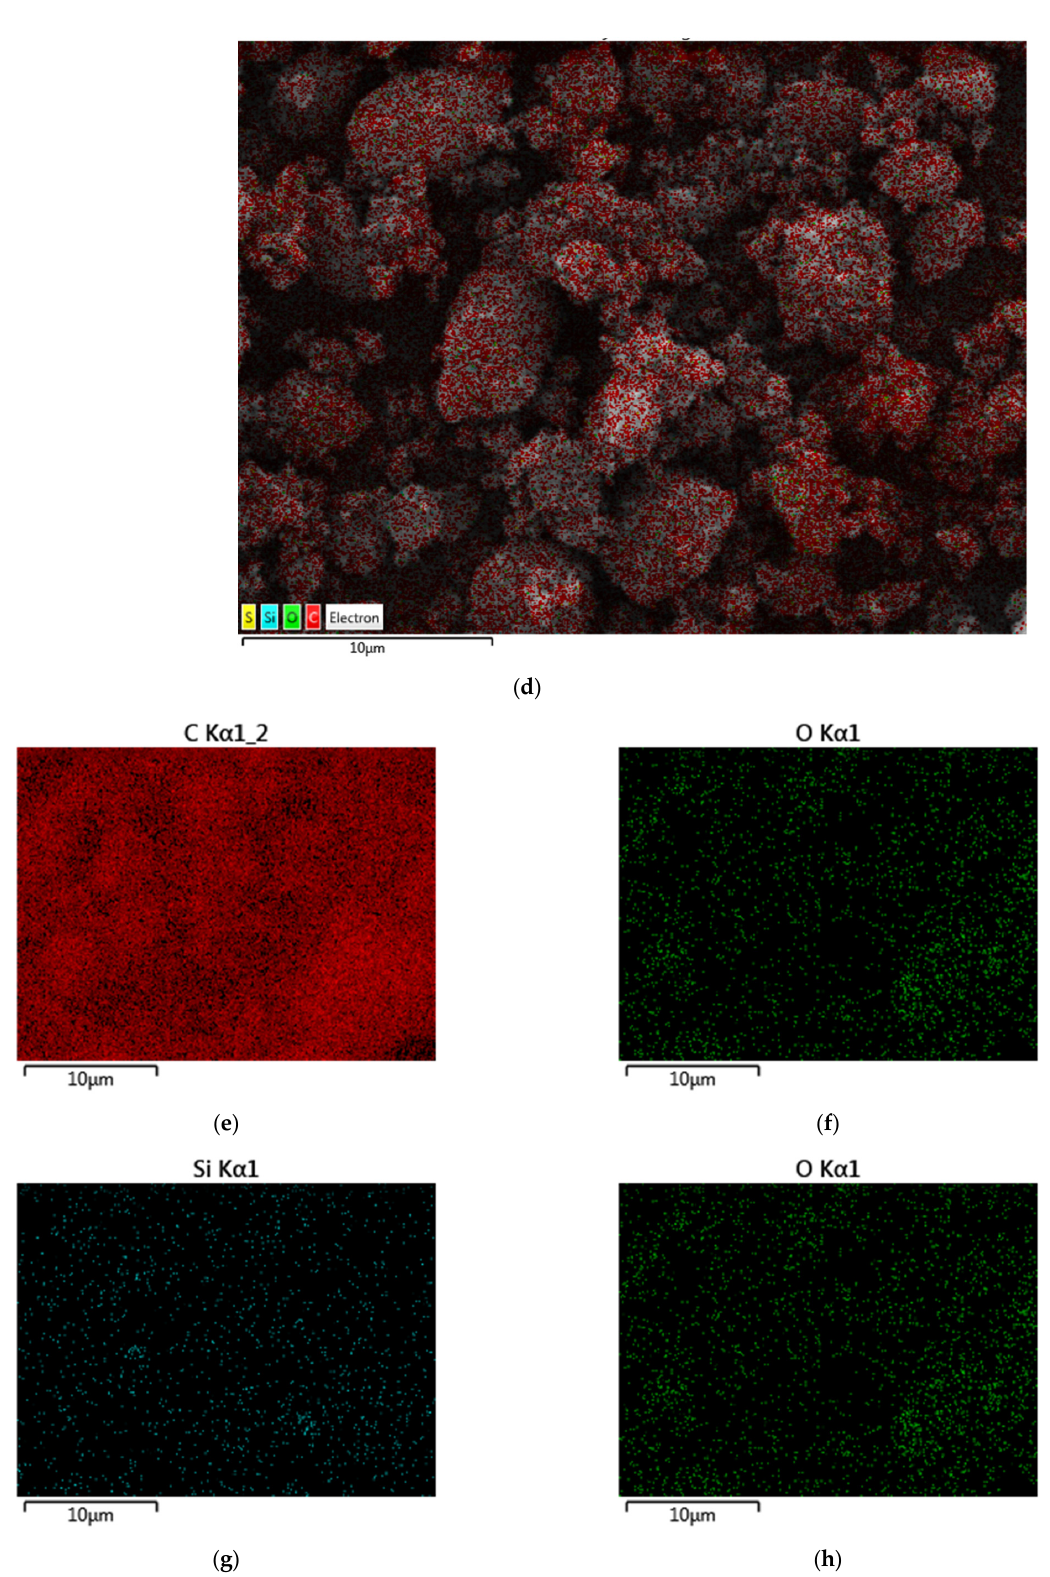
Figure 6. SEM and EDX mapping examination of CF-GNPs; ( a ) SEM image, ( b ) EDX mapping analysis, ( c ) EDX elemental analysis, ( d ) EDS layered image; ( e ) carbon (C) mapping; ( f ) oxygen (O) mapping; ( g ) silicon (Si) mapping; and ( h ) sulfur (S)